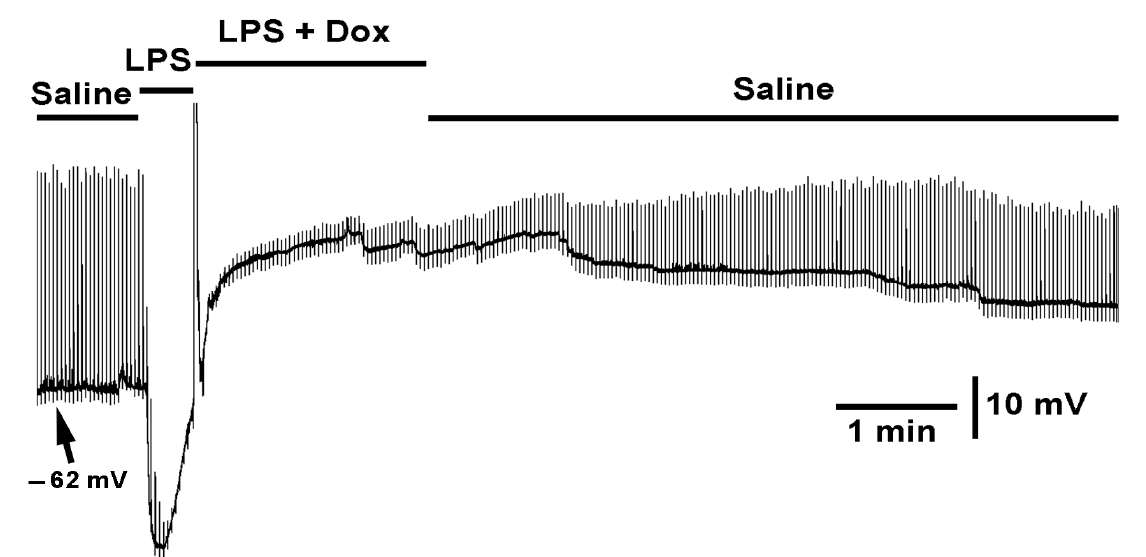
Figure 10. The effect of LPS and the cocktail of LPS with doxapram on membrane potential and evoked EJPs. The segmental nerve was stimulated at a rate of 0.5 Hz. LPS rapidly hyperpolarized the membrane and depressed evoked synaptic transmission. The bath exchange to LPS and doxapram (10 mM) rapidly depolarized the membrane and does not fully relive the action of LPS in blocking synaptic transmission but allowed the synaptic response to increase in amplitude.